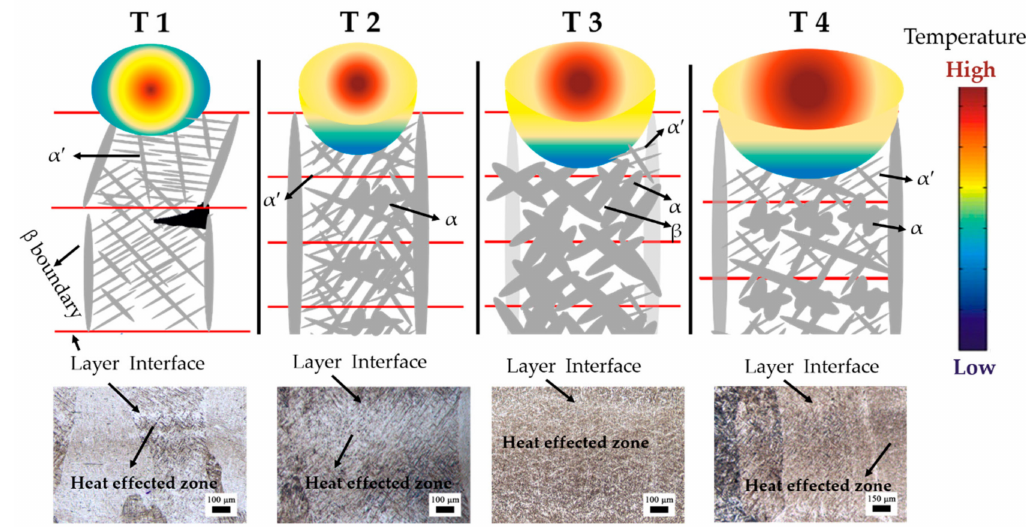
Figure 13. The schematic micro-structure forming mechanism of present laser melting deposition (LMD) Ti6Al4V